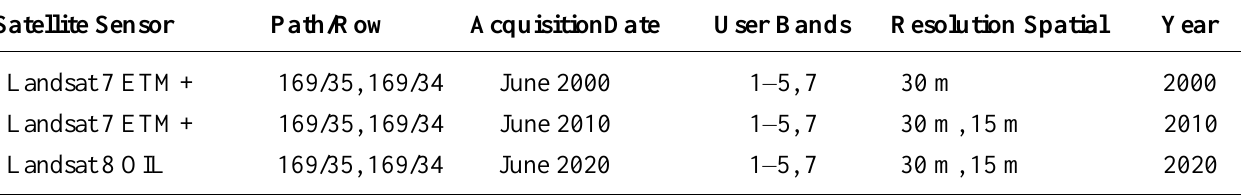
Table 1 . Details of the Landsat image data were used to analyse the research area's land use and land cover